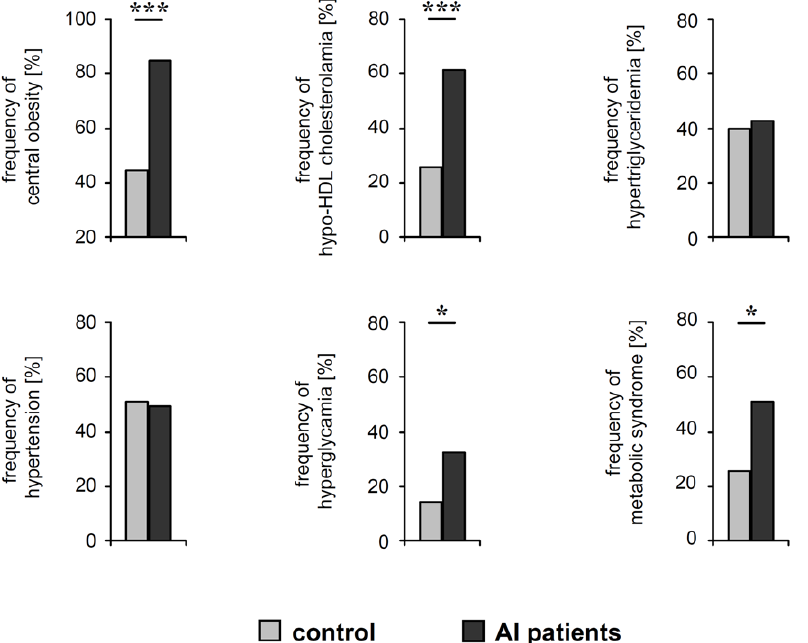
Figure 3. Frequency of fulfilled criteria for metabolic syndrome in overweight and obese AI patients and control participants. The frequency of central obesity, hypo-HDL-cholesterolemia, hypertriglyceridemia, hypertension, hyperglycemia in AI patients (n=59) and controls (n=43) with a BMI of 25 or higher are given. Significance of differences was assessed by the Chi-square test (* P , 0.05, *** P , 0.001).